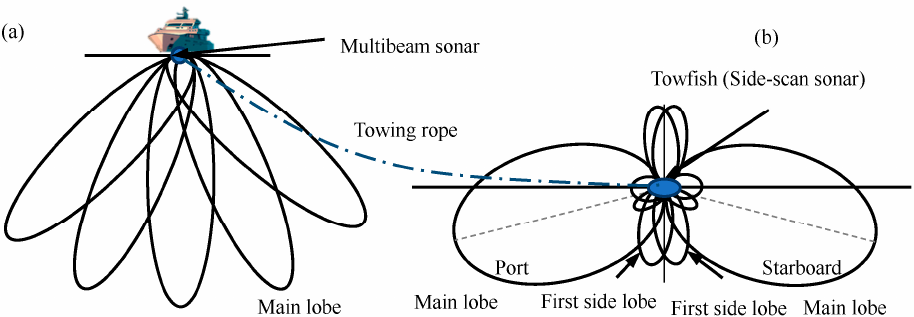
Figure 1. Operating modes and beam patterns of multibeam echo sounders (MBES) ( a ) and side scan sonars (SSS) ( b ).